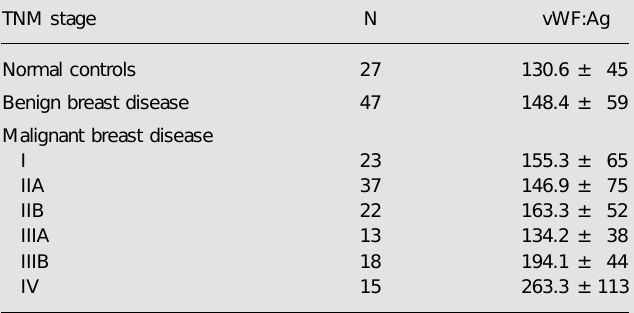
Table 2. von Willebrand factor antigen (vWF:Ag) levels in patients with breast cancer according to stage of the disease determined by the TNM system